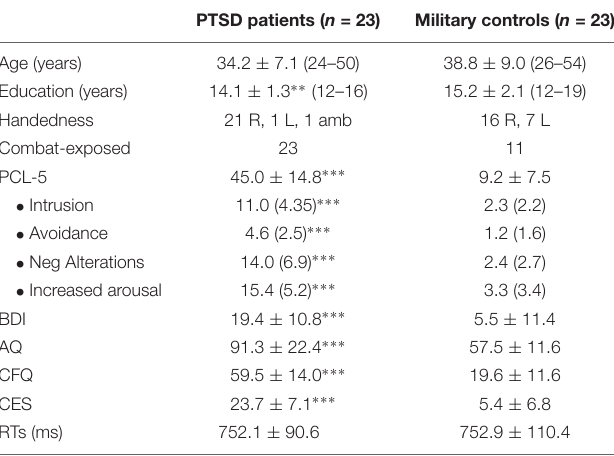
TABLE 1 | Demographic information and symptom severity scores for participants with PTSD and military controls. PTSD patients ( n = 23)